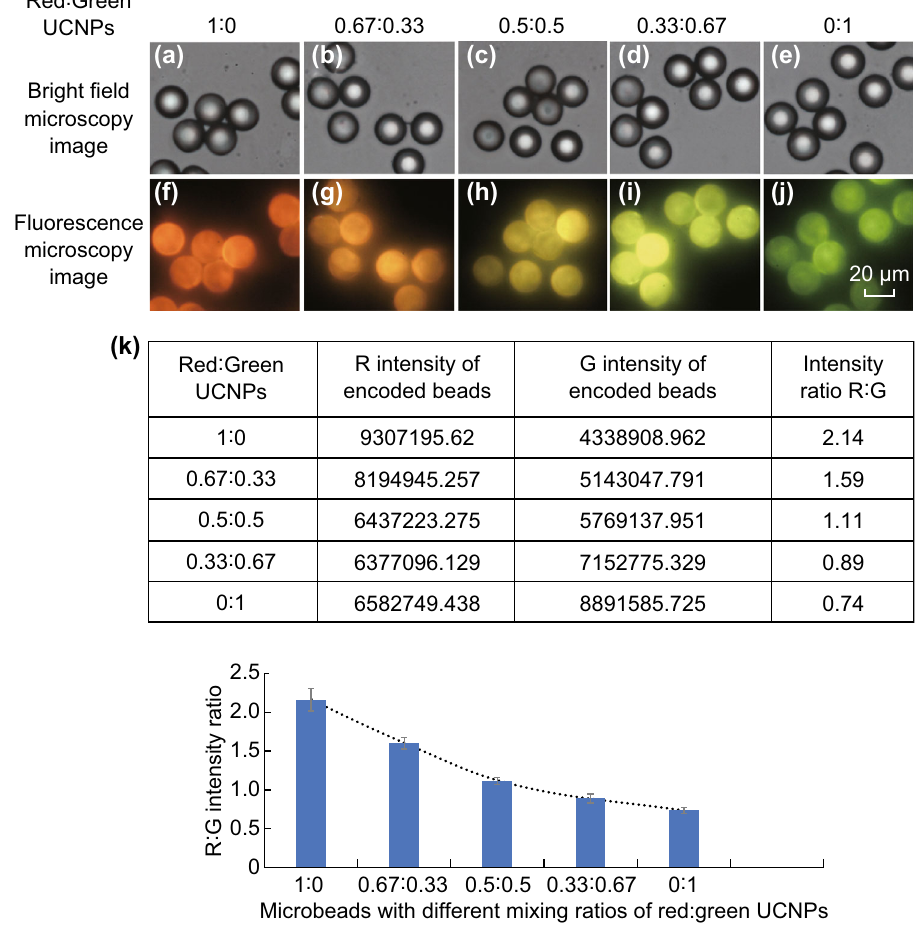
Fig. 4 Bright field microscopy images and their corresponding fluorescent microscopy images (at 40 9 magnification) of microbeads encoded with carboxyl-modified NaYF 4 :50%Yb,1%Er and NaYF 4 :18%Yb2%Er30%Lu UCNPs at ratios of a, f 1:0, b, g 0.67:0.33, c, h 0.5:0.5, d, i 0.33:0.67, and e, j 0:1, k Ratio of red and green intensity calculated from each microbeads (top) and the corresponding graph (bottom) (data represent mean ± SD; n = 20 microbeads). (Color figure